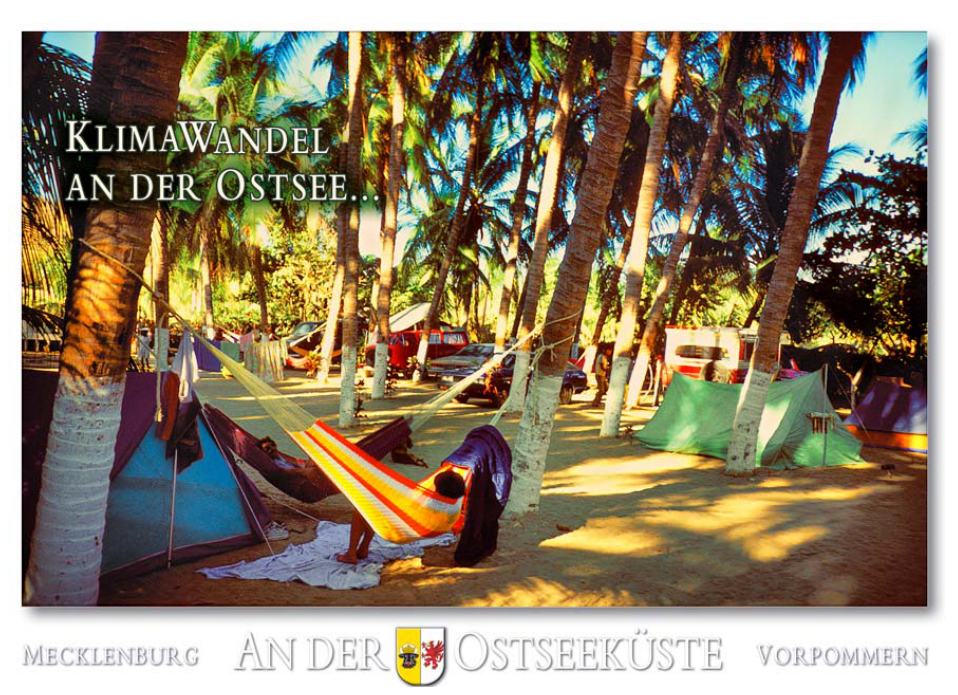
Figure 3. Resilience constructions in Rostock: rising temperatures and tourism.